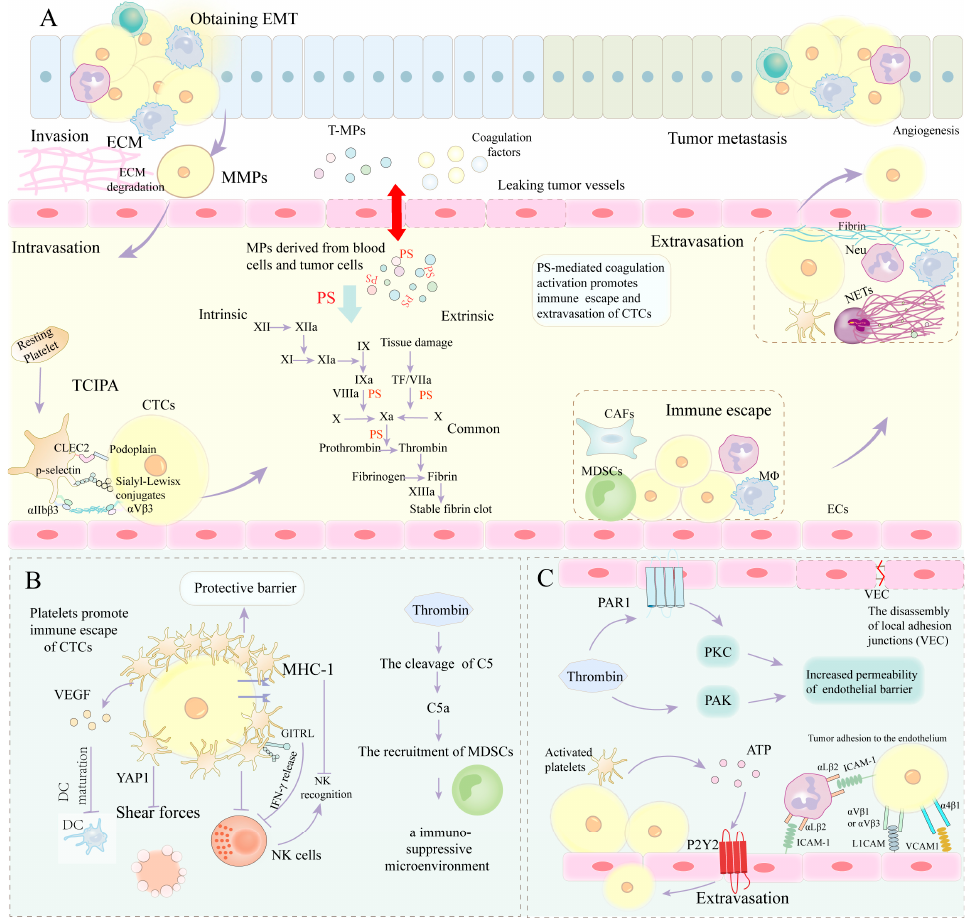
Figure 2. PS-mediated coagulation cascade involved in tumor progression. ( A ) Following platelet activation, platelets tightly bind to tumor cells by various adhesion receptors and promote CTC survival and immune escape. PS on MPs derived from tumor cells and blood cells mediate the coagulation cascade. PS-mediated coagulation cascade protects CTCs from the shear forces of blood flow and immune cell attack. Coagulation activation further promotes the extravasation of CTCs. Coagulation factors enter the tumor microenvironment by leaking tumor vessels and are involved in EMT, ECM degradation, and angiogenesis. ( B ) Platelets promote immune escape of CTCs via multiple mechanisms. Thrombin can directly cleave C5 to generate C5a, which induces an immuno- suppressive microenvironment by the recruitment of MDSCs. ( C ) In addition to through integrin α 4 β 1, α V β 1 or α V β 3, tumor cells can adhere to endothelium with the help of leukocytes. Activated platelets release ATP from dense granules, activate endothelial P2Y2 receptors and allow trans- endothelial migration of tumor cells by increasing the permeability of blood vessels. Thrombin acti- vates PKC pathways or mediates PAK activity to increase the permeability of the endothelial barrier. EMT: epithelial-mesenchymal transition; ECM: extracellular matrix; MMPs: matrix metal- loproteinases; T-MPs: tumor-derived MPs; TCIPA: tumor cell-induced platelet aggregation; CLEC-2: C-type lectin-like receptor 2, CTCs: circulating tumor cells; PS: Phosphatidylserine; CAFs: cancer-associated fibroblasts; MDSCs: myeloid-derived suppressor cells; mø: Macrophages; Neu: Neutrophils; NETs: Neutrophil extracellular traps, DC: Dendritic cells, YAP1: yes-associated protein- 1, GITRL: the glucocorticoid-induced tumor necrosis factor receptor ligand; NK: natural killer, PKC: protein kinase C; PAK; p21-activated kinase, VEC: VE-cadherin, ICAM-1: intercellular adhe- sion molecule 1, VCAM1: vascular cell adhesion molecule-1,L1CAM: L1cell adhesion molecular; ECs: Endothelial cells; VEGF: Vascular endothelial growth